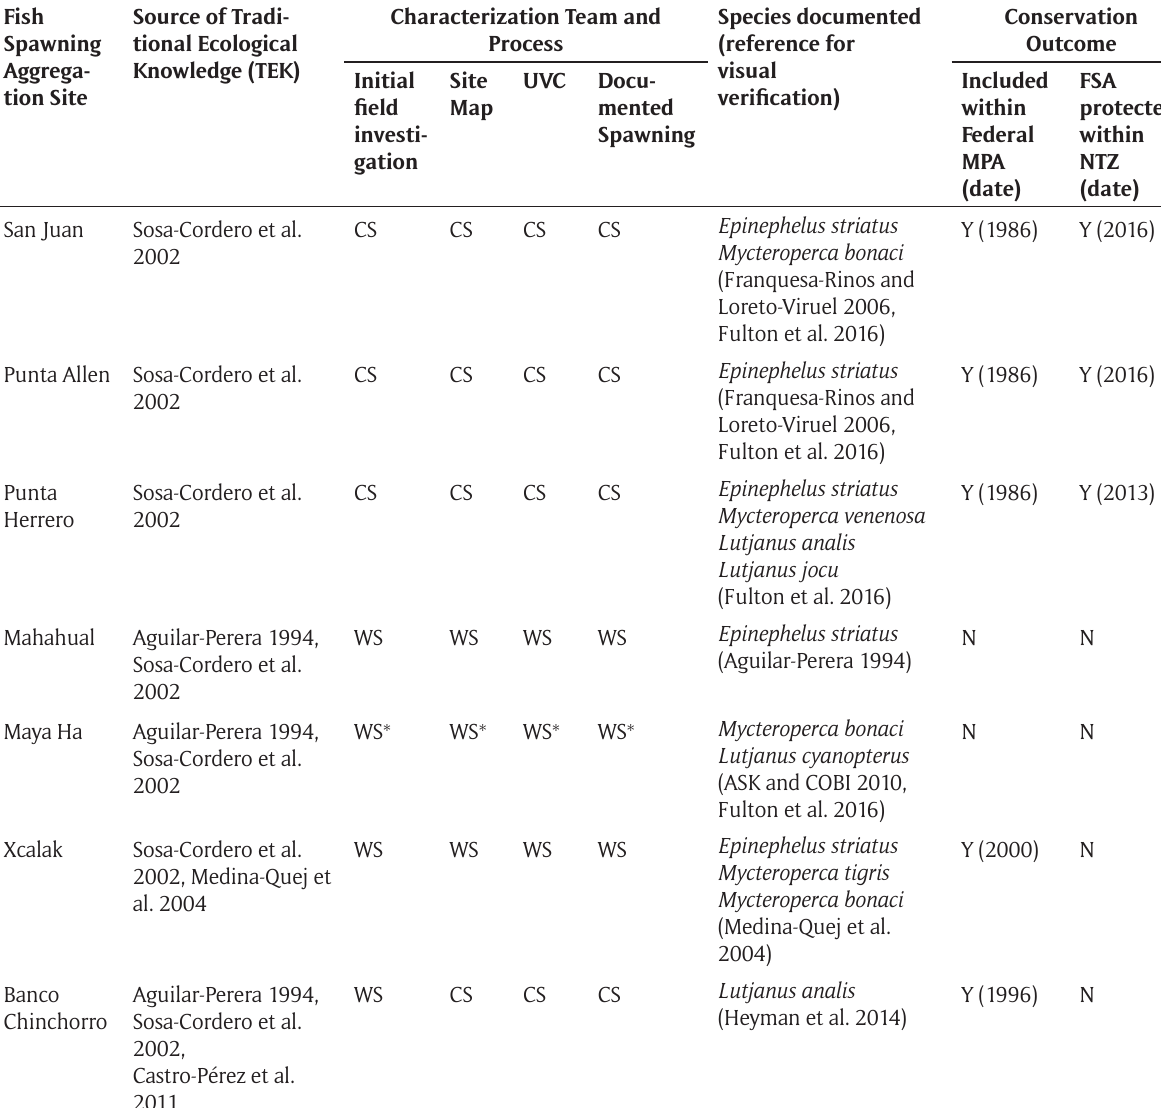
Table 1: Current status of verified fish spawning aggregation sites in central and southern Quintana Roo. Fish Spawning